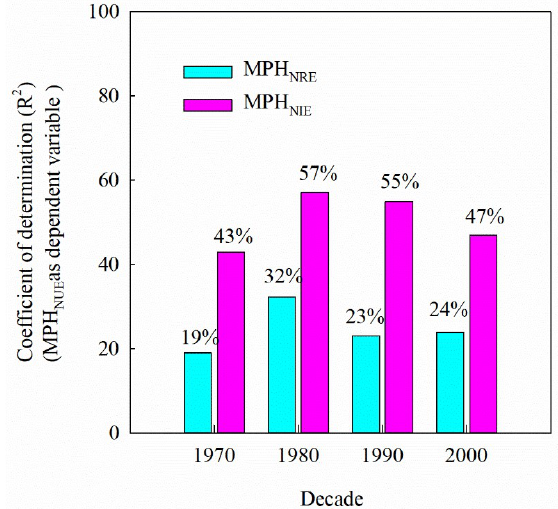
Figure 3. Coefficient of determination (R 2 ) of MPH NUE (dependent variable) versus MPH NIE and MPH NRE of maize hybrids in different decades.